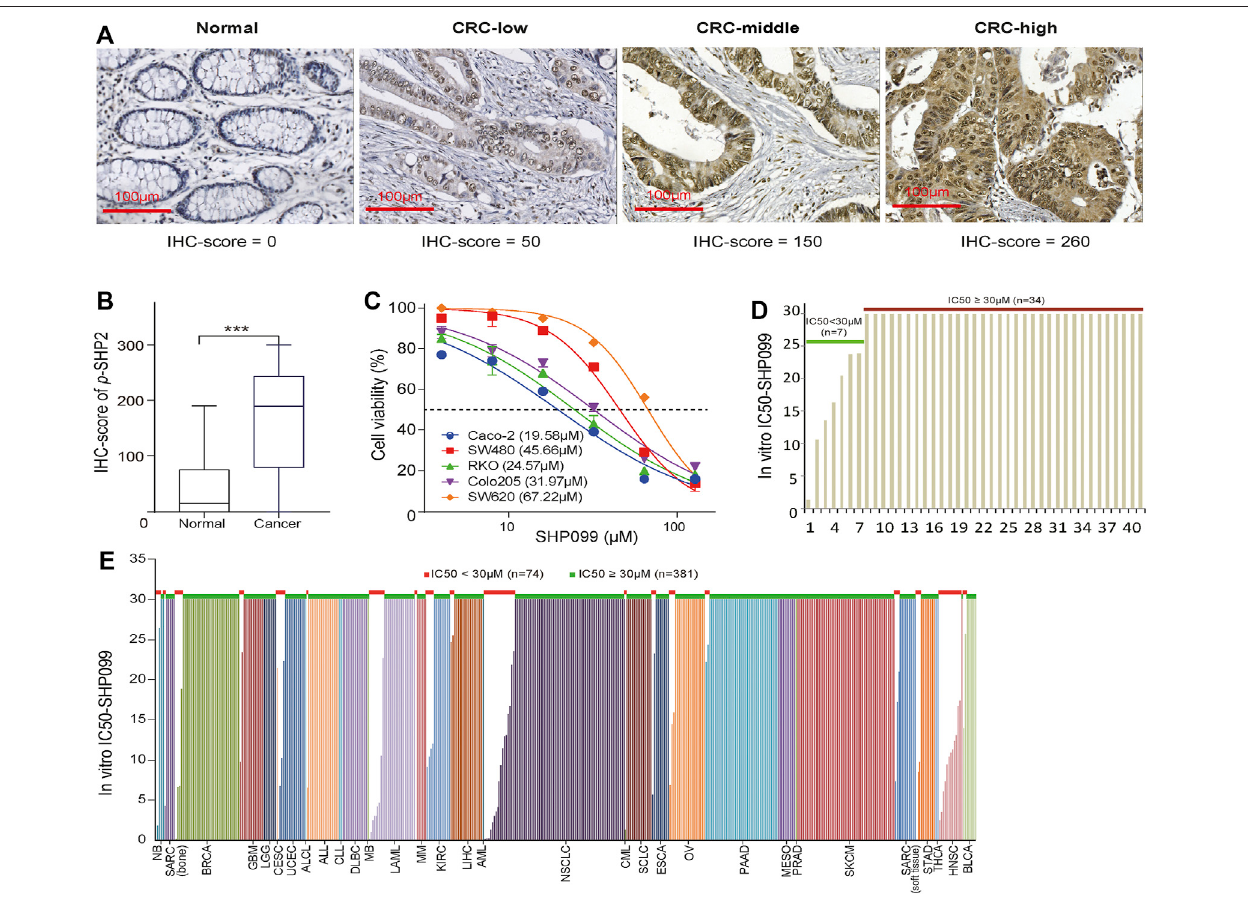
FIGURE 1 | The expression of p-SHP2 in CRC and the activity of its inhibitor (SHP099) in cancer cells. (A) Representative images of p-SHP2 expression in colorectal tissues based on IHC. (B) Increased p-SHP2 expression in CRC. (*** < 0.001) (C) Activity of SHP099 in 5 CRC cell lines with indicated IC50s. (D) Analyses of IC 50 values of SHP099 in 41 CRC cell lines. (E) Analyses of IC 50 values of SHP099 in 455 cancer cell lines excluding CRC cell lines. CRC: colorectal cancer; IHC: immunohistochemistry; IC 50 : the half maximal inhibitory